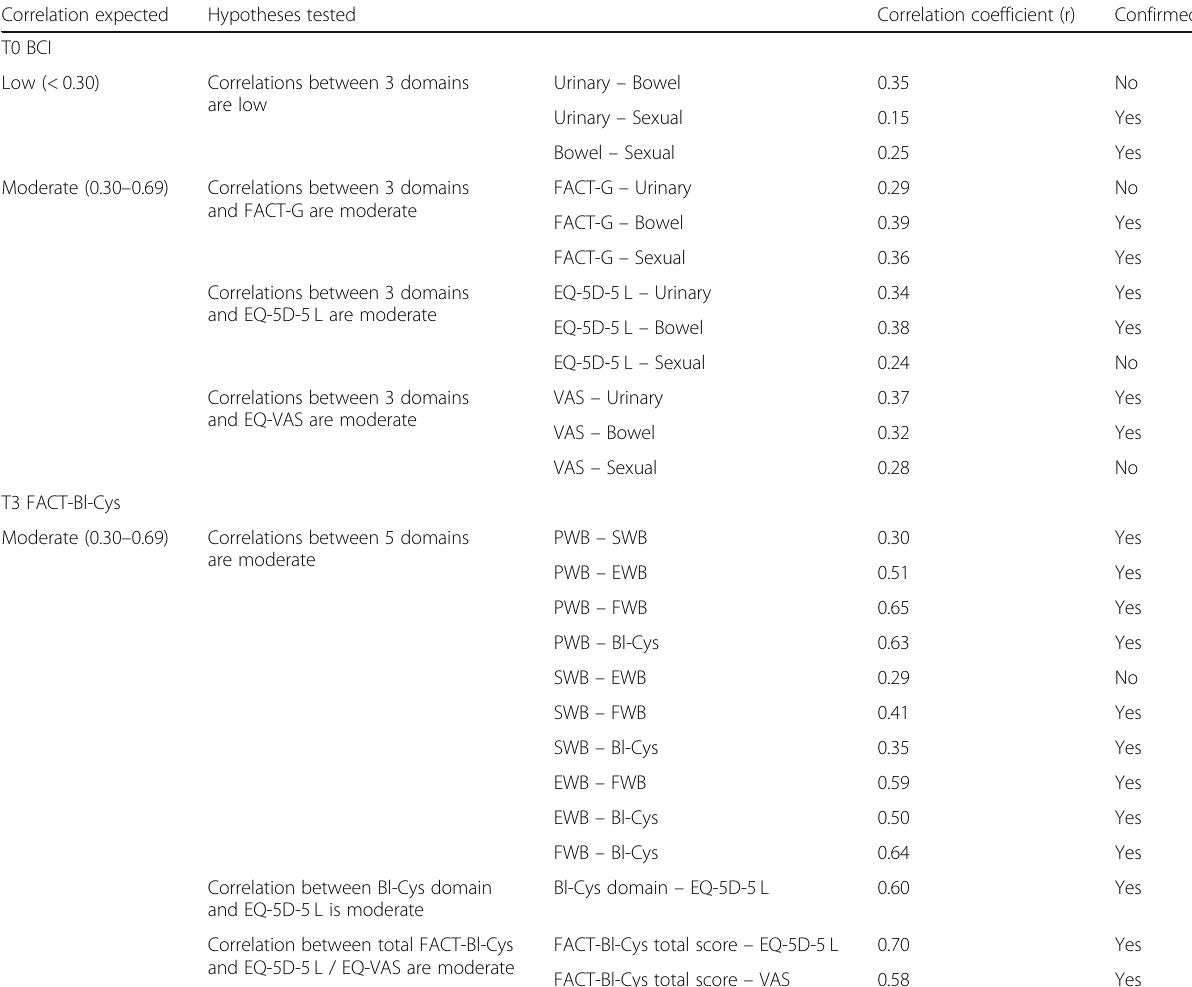
Table 5 Construct validity properties of the BCI and